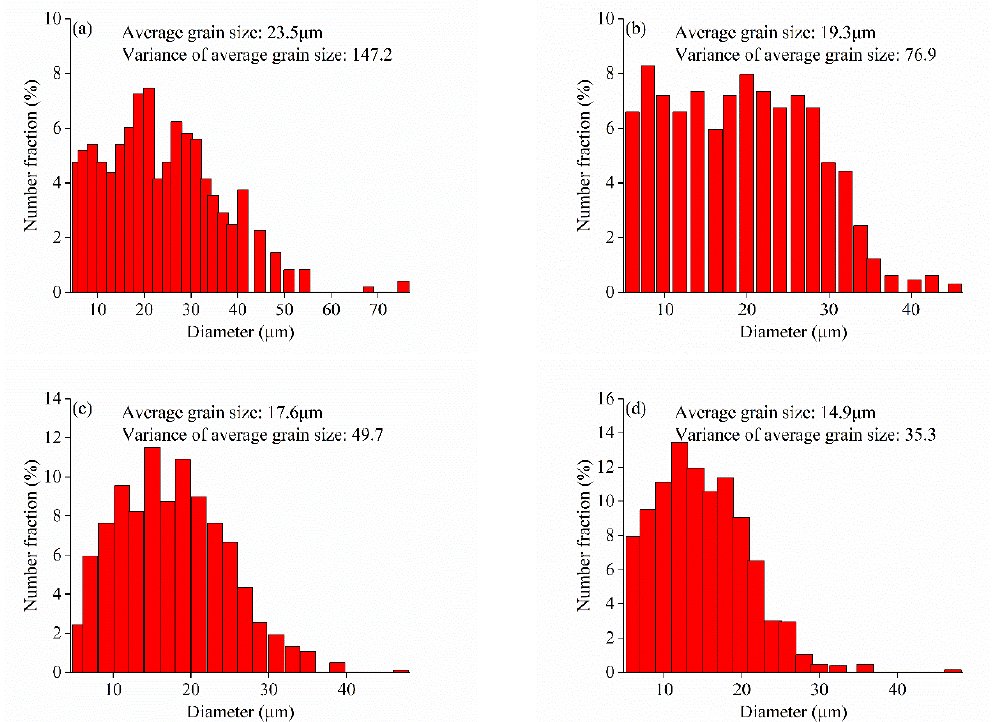
Figure 13. Distributions of grains size of Mg–7Gd–5Y– x Zn–0.5Zr alloys displayed by EBSD images: ( a ) x = 0 wt%; ( b ) x = 3 wt%; ( c ) x = 5 wt%; ( d ) x = 7 wt%.